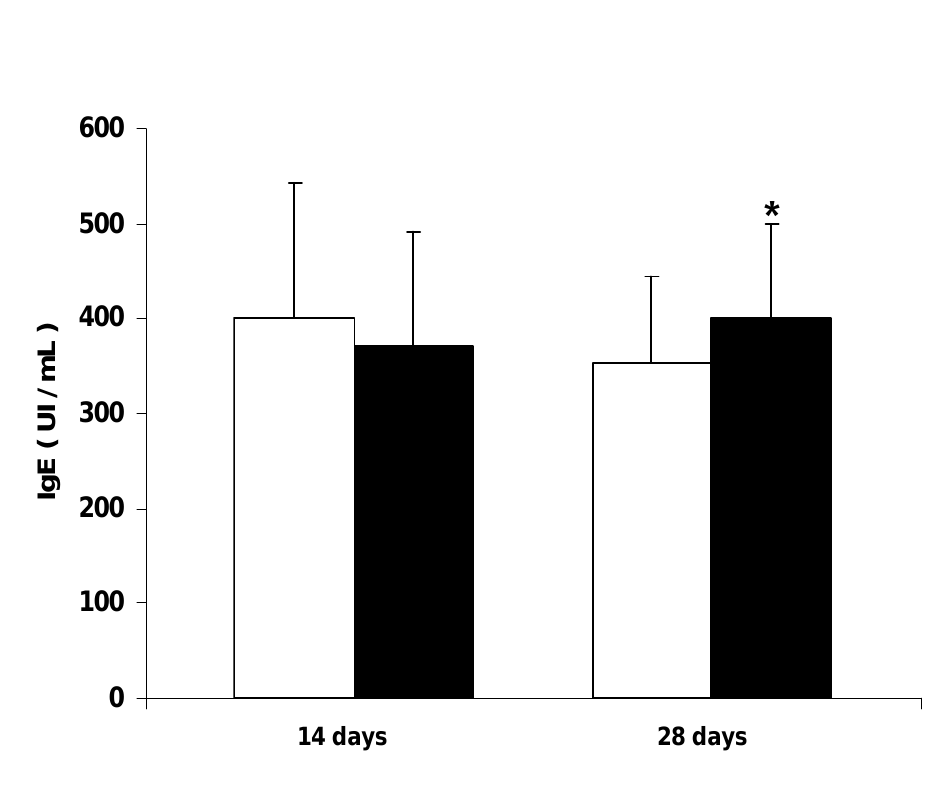
Figure 4: IgE serum levels in patients evaluated before and after 14 and 28 days of treatment with rabies serum vaccination. Results are expressed as mean + SD of UI/ml. * ( p <0.05) paired t